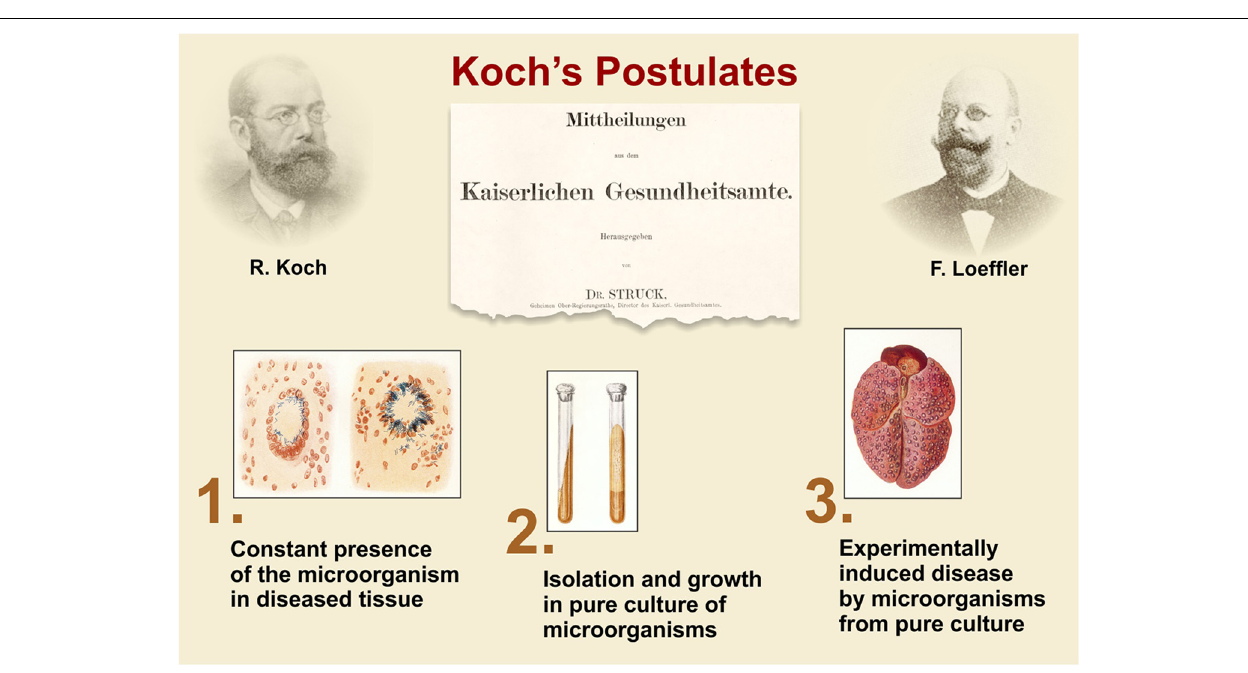
FIGURE 2 | Koch’s postulates, based on Robert Koch’s lecture on the etiology of TB and phrased in general terms by F. Loeffler (Loeffler, 1884; Kaufmann and Winau,